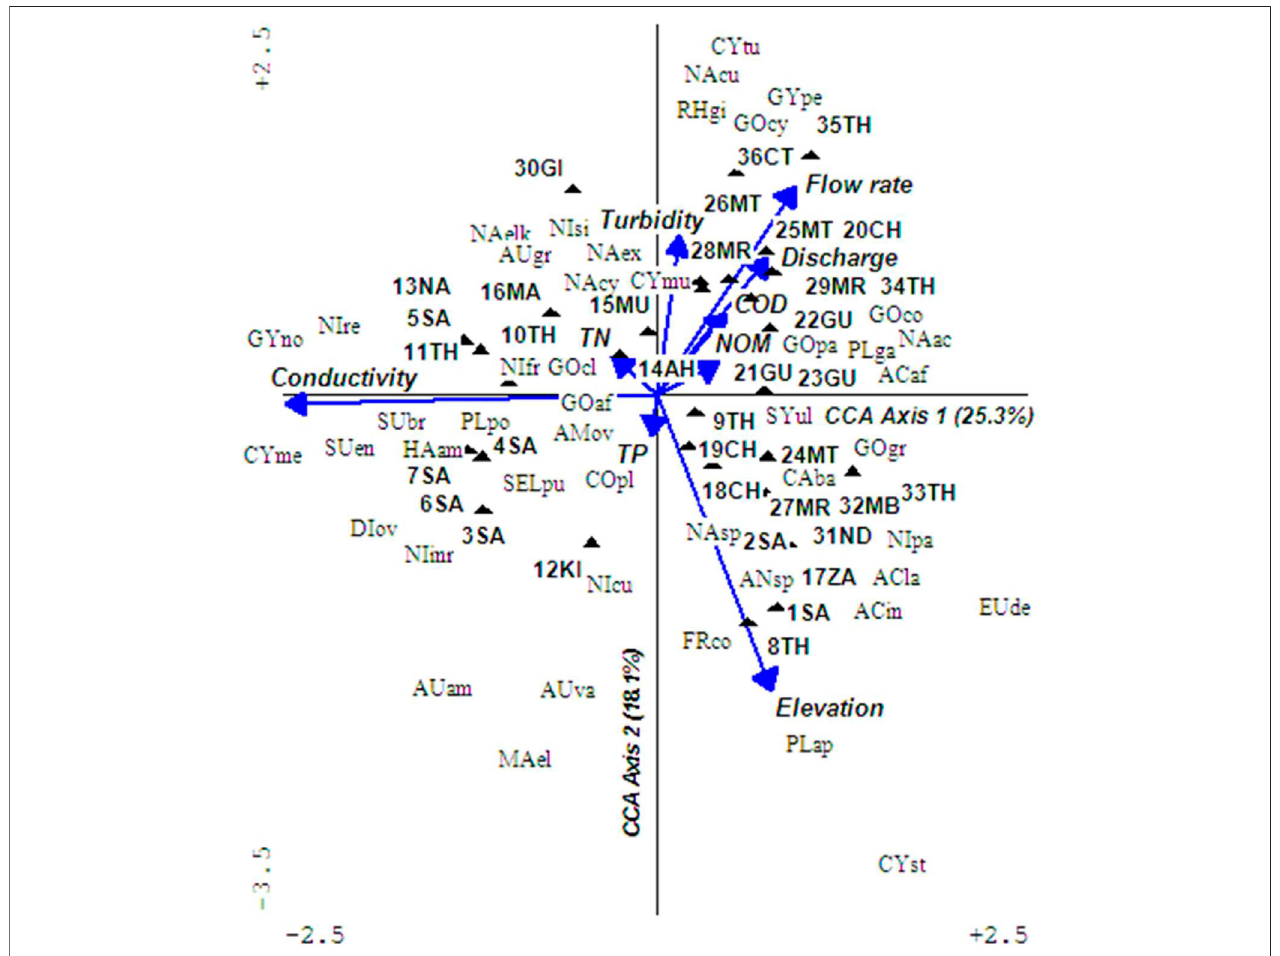
FIGURE5| Atriplotofdiatomassemblagesfoundincobblemicrohabitatandwaterqualityduringthedryseason.The fi rstaxisandallaxistestsreturnedsigni fi cant relationships,thatis,F (cid:2) 2.37, p (cid:2) 0.03andF (cid:2) 1.43, p (cid:2) 0.01,respectively,implyingvariationofdiatomsexplainedbywaterqualityonthetriplotwasstronglysigni fi cant. Arrowrepresentswaterqualityparametersand fi lledtrianglesampledsites.Theabbreviatedfour-letterlabelssignifydiatomswiththe fi rsttwouppercaselettersstanding for genus and the next two lower case letters for species. Full diatom species names are provided as Supplementary Table S3 .